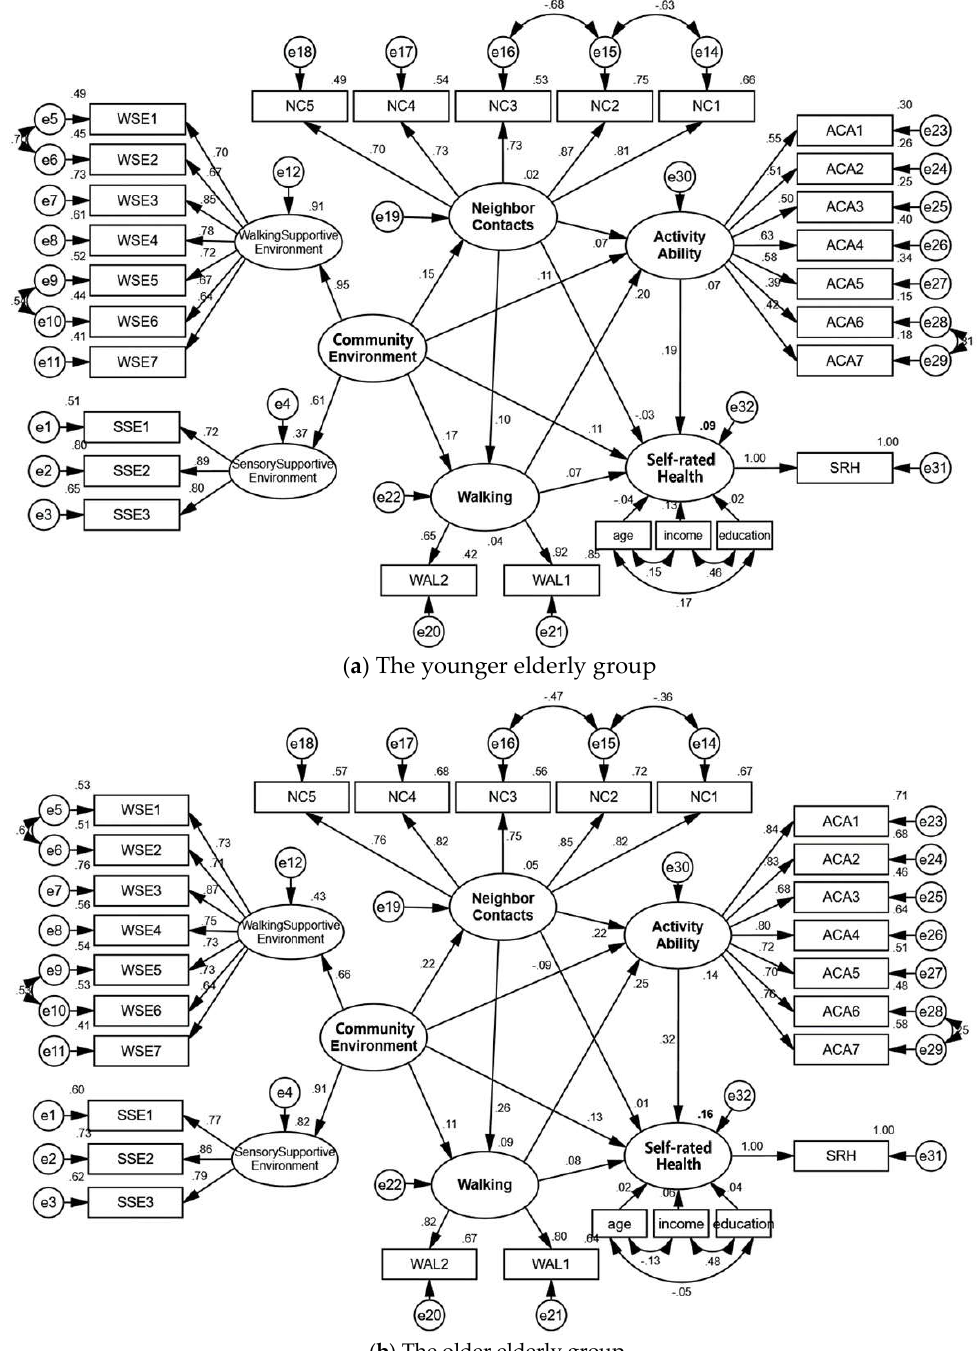
Figure 4. Comparison of models for different age groups. The activity ability of the younger elderly group was positively influenced by the com- munity environment, neighbor contacts, and walking, with total effect values of 0.155, 0.091, and 0.201, respectively. The direct effect of the community environment and neighbor con- tacts on the activity ability of the younger elderly group was not significant, while the indi- rect effect was significant. The community environment, walking, and activity ability showed a significant positive effect on the self-rated health of the younger elderly group, with total effect values of 0.152, 0.107, and 0.192, respectively, while the neighbor contact did not. Both the direct and indirect effects of the community environment on the younger elderly group’s self-rated health were significant, but the direct effects of neighbor contacts and walking were not significant. Neighbor contacts and walking showed a significant pos- itive effect on the activity ability of the older group of old people, with total effect values of 0.285 and 0.252, respectively. Community environment had no significant effect on their activity ability. The self-rated health of the older elderly group was significantly and posi- tively influenced by the community environment, neighbor contacts, walking, and activity ability, with total effect values of 0.142, 0.126, 0.165, and 0.319, respectively. 4. Discussion This study explored the relationship between the community environment, behavior, and the health of older adults. We focused more on the differences of this relationship at two levels (overall vs. age groups) and two dimensions (subjective health assessment and objective activity ability). Our study confirmed the conclusion of some scholars that the community environ- ment, walking, and neighbor contacts have significant positive effects on the activity abil- ity and self-rated health of older adults [5,18–20,35]. In addition, our research found that the community environment and the behavior of older adults have different effects on their activity ability and self-rated health. These different effects are detailed as follows. Firstly, the community environment has wider effects on older adults’ self-rated health, while behavior, including walking behavior and neighbor contacts, has a more intensive effect on the activity ability of older adults. This conclusion not only reveals the